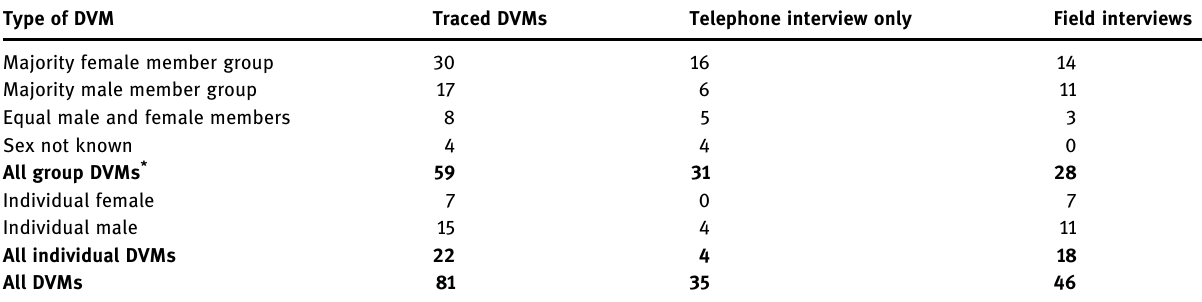
Table 1: DVMs interviewed by type of interview, Lake Zone, Tanzania, October 2017 – December